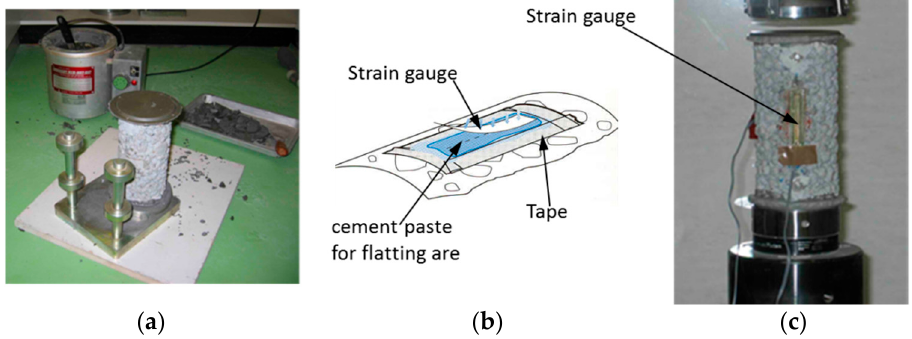
Figure 5. Testing process of elastic modulus of pervious concrete. ( a ) The equipment for capping cylinders and a capped cylinder; ( b ) a schematic drawing for how to attach strain gages; and ( c ) sample during testing.